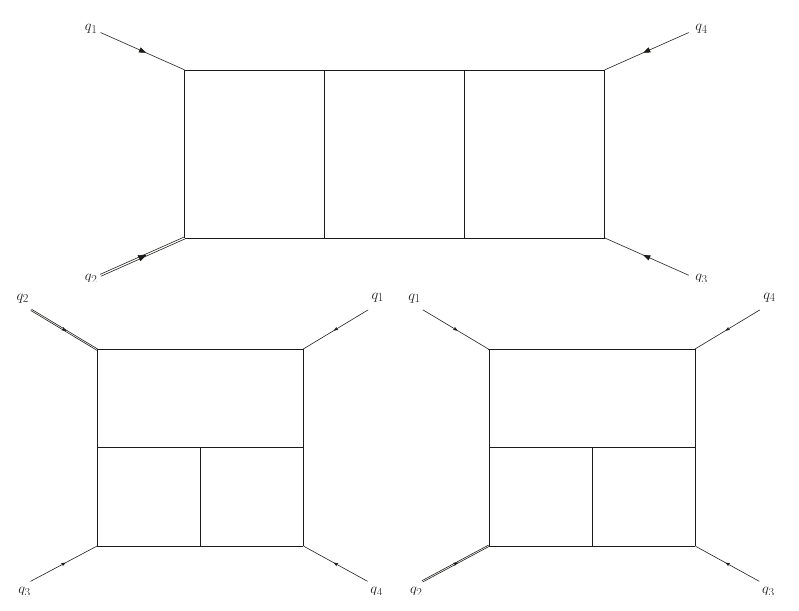
Figure 1 . The F1 (top), F2 (bottom left) and F3 (bottom right) top-sector diagrams. The double line represents the massive particle and all external momenta are taken to be